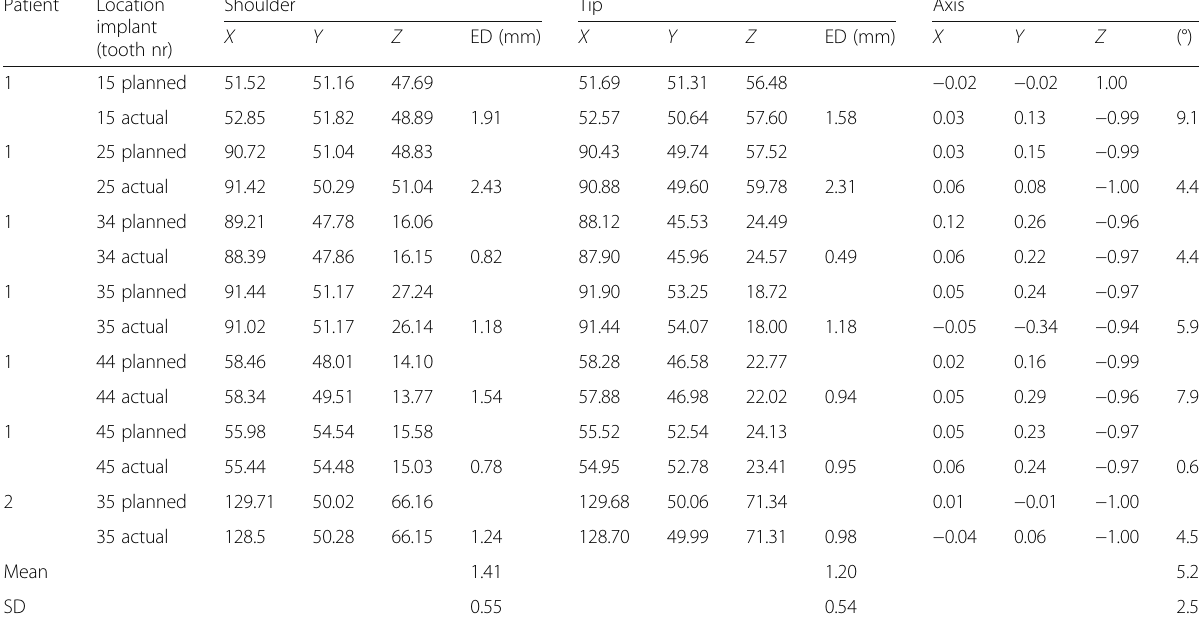
Table 1 Accuracy data: Euclidian distances (ED, mm) of the apex (tip) and entry point (shoulder) and the degree (°) of angular deviation (axis) of the implants ( n = 7) Patient Location implant